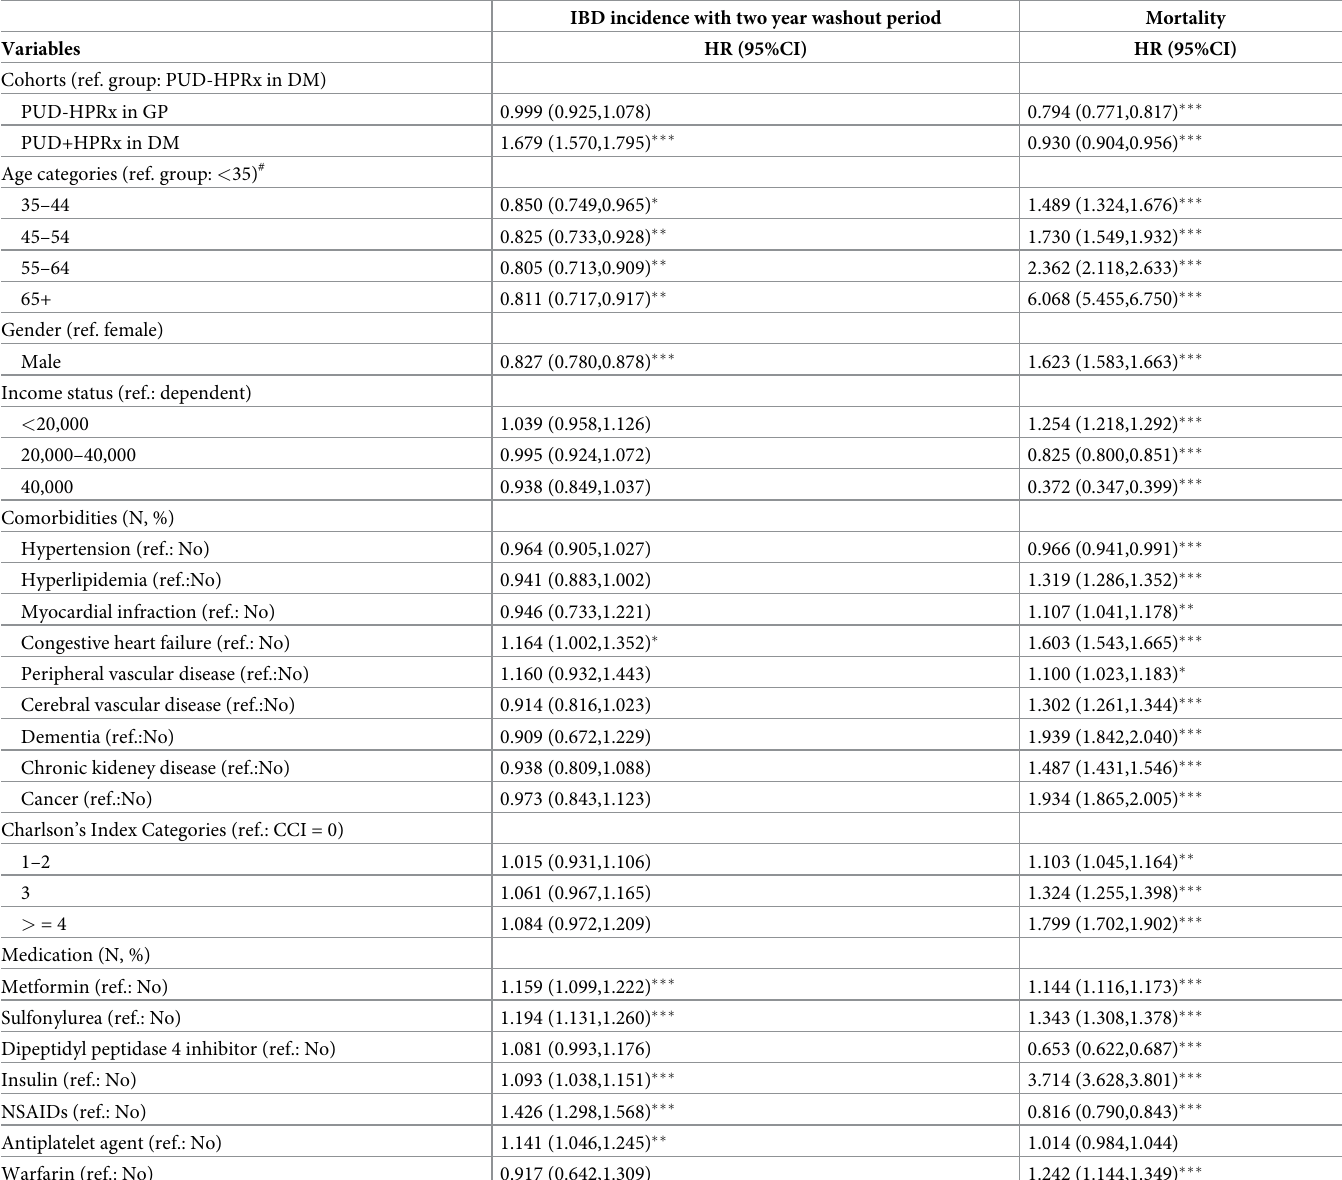
Table 3. Cox proportional hazards model assessment of outcomes of inflammatory bowel disease and mortality in the matched